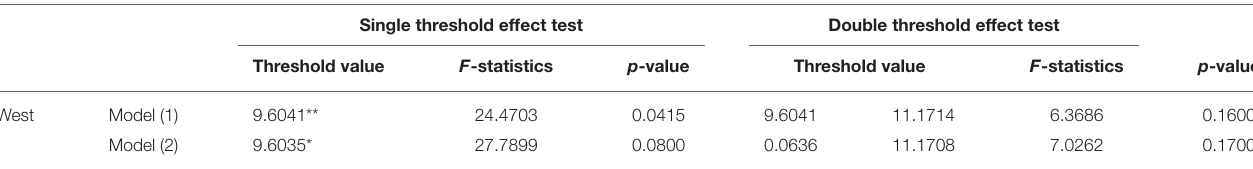
TABLE 8 | Results of threshold effects between air pollution and health care expenditure.